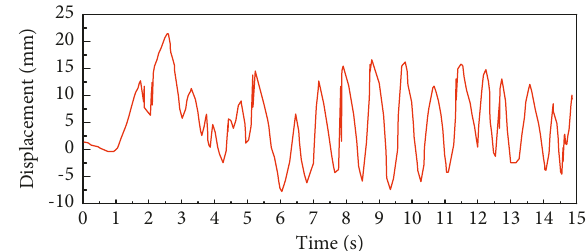
Figure 13: Horizontal displacement time curve of trestle truss at observation point 10.